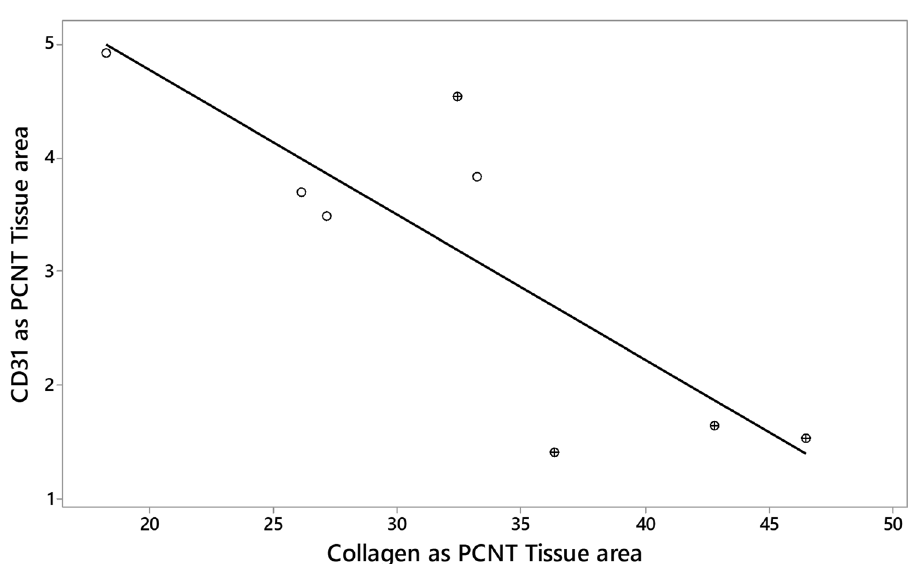
Figure 5. Relationship between collagen and CD31 expression in sheep during the chronic response to radiation. For each sheep the average values for collagen (Picrosirius Red) and CD31 stain area were calculated for each radio-exposed ( ⊗ ) and contralateral control (Ο) lung and plotted against each other. A significant negative association existed between these variables (Pearson correlation = − 0.829; P-Value =